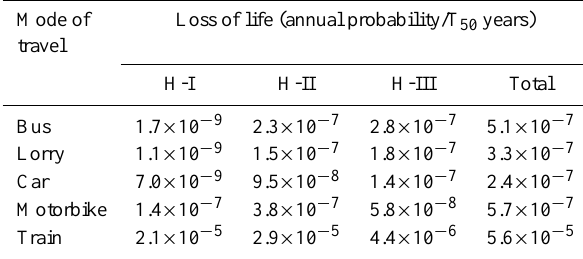
Table 7. Direct specific risk for vehicles and train. Elements at risk Type